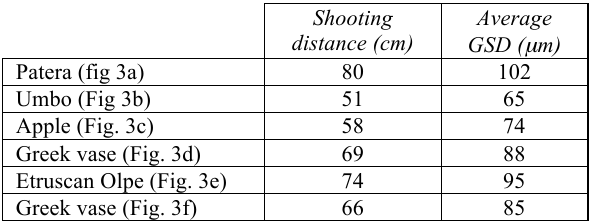
Table 1. Shooting distances and average GSDs.